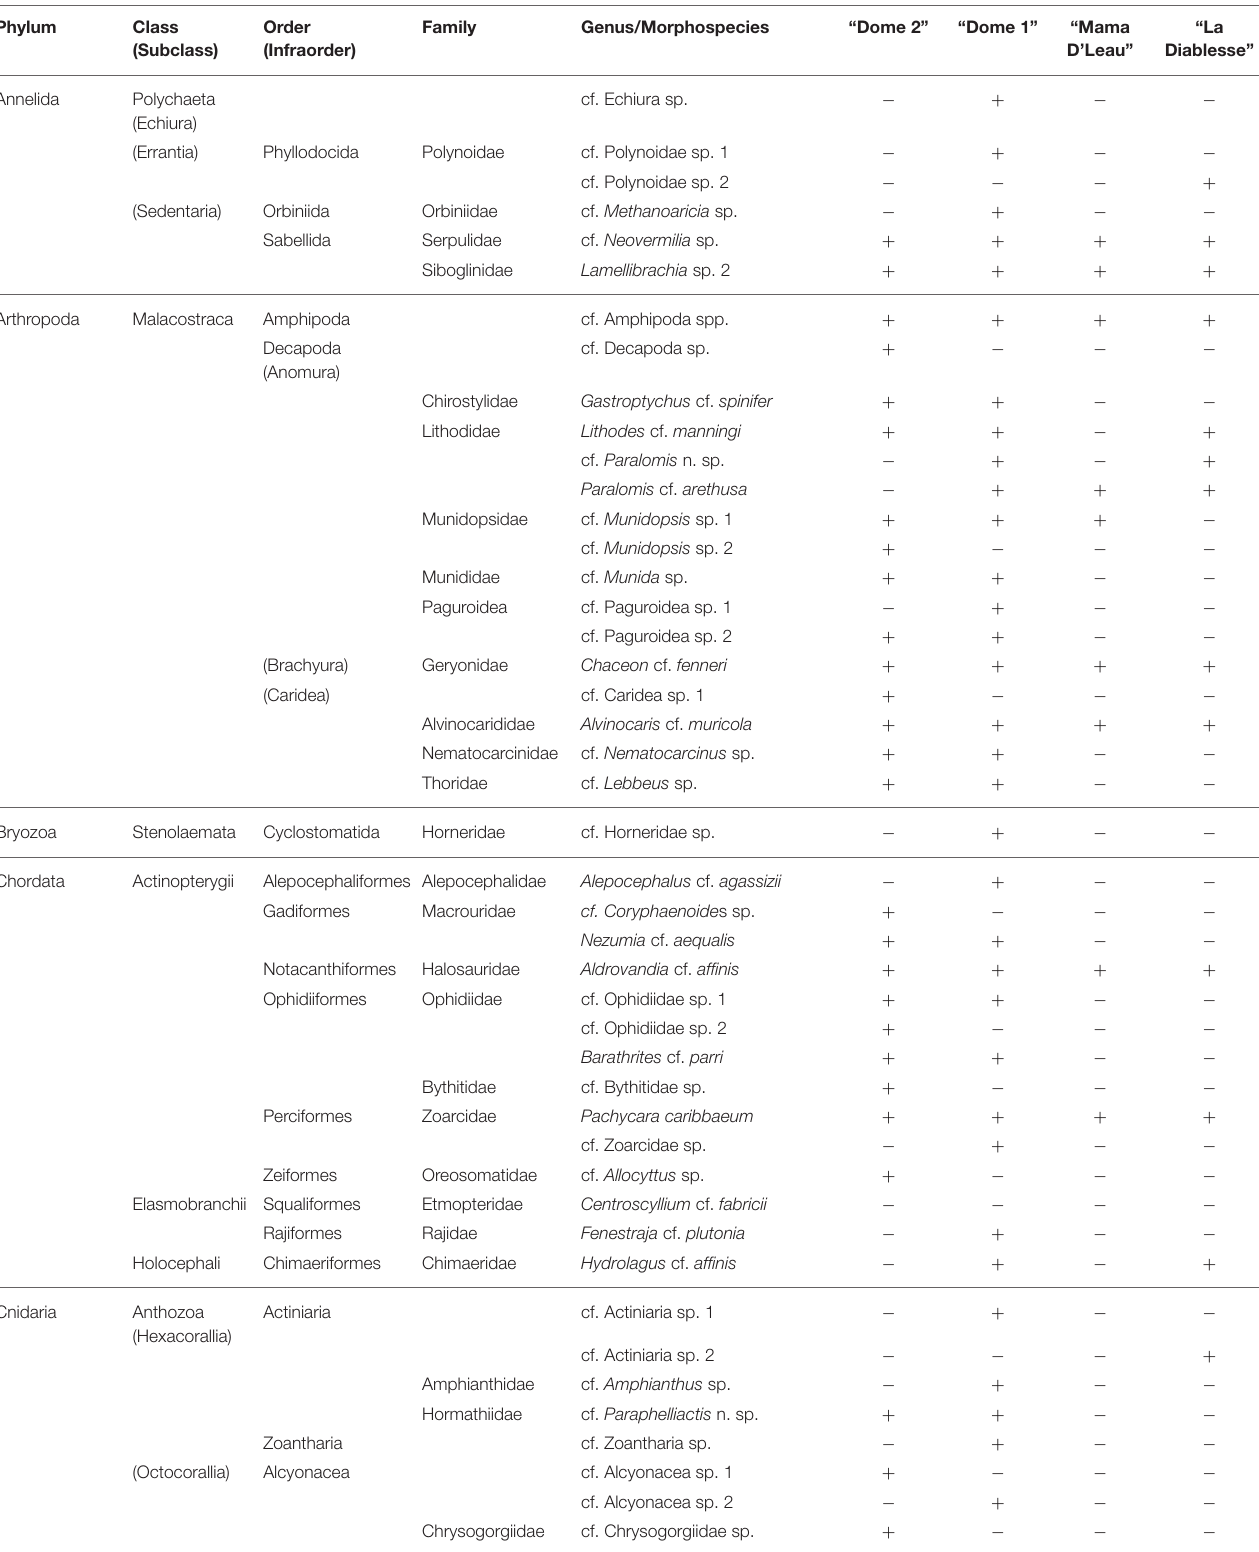
TABLE 2 | Megafaunal morphospecies observed from all imagery collected during NA054 off Trinidad and Tobago.